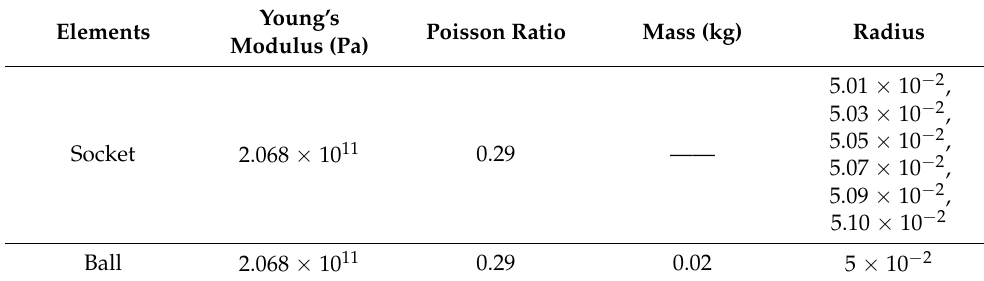
Table 1. Structure parameters of the spherical joint with clearance. Elements